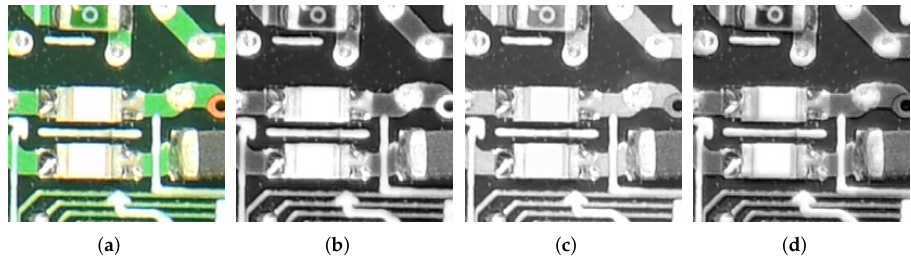
Figure 4. ( a ) The Original PCB Image; ( b ) R Channel of the Image; ( c ) G Channel of the Image; ( d ) B Channel of The